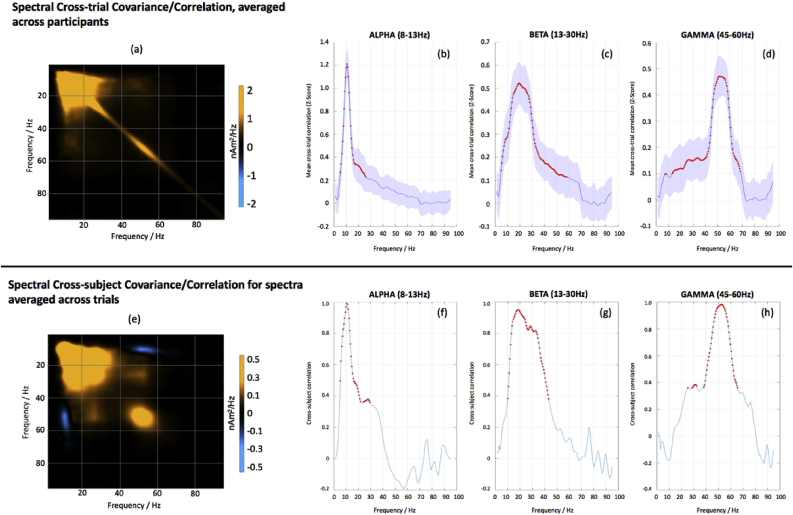
(a) and (e) shows the covariance of the spectral amplitudes, during visual stimulation, calculated either by averaging the mean inter-trial covariance across participants (a) or looking at how the spectral estimates, averaged over trials, co-vary across participants, (e). In both cases the amplitude of the lower frequencies (0–30 Hz) appears correlated across frequencies, whereas the induced gamma response at 40–60 Hz appears less correlated, suggesting separate generative mechanisms. For each of these two analyses, panels b–d and f–h show the cross-correlation of the spectra for alpha, beta and gamma, either across trials (top row) or subjects (bottom row). Red dots demonstrate significant correlations (p < 0.05 corrected for multiple comparisons). Note how correlations are strongest within frequency bands. Panels f–h demonstrate the across-trials correlation after z-transforming and averaging over subjects for the same frequency bands. The shaded bars represent the standard deviation of the Z-score across subjects.